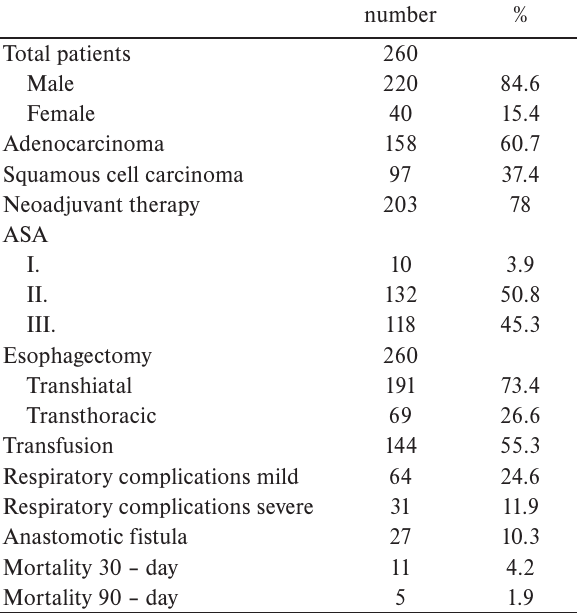
Table 1. Characteristics of patients operated for esophageal cancer from 2006-2017.